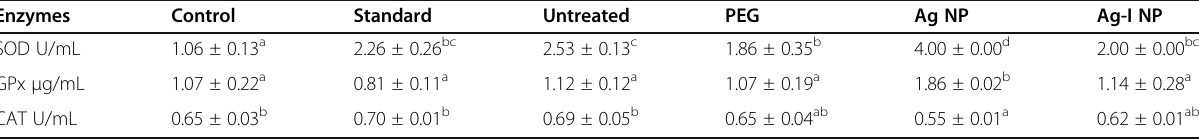
Table 2 Effects of 21 days treatment of wound with PEG, Ag-np and Ag-INP on antioxidant enzymes of albino rats Enzymes